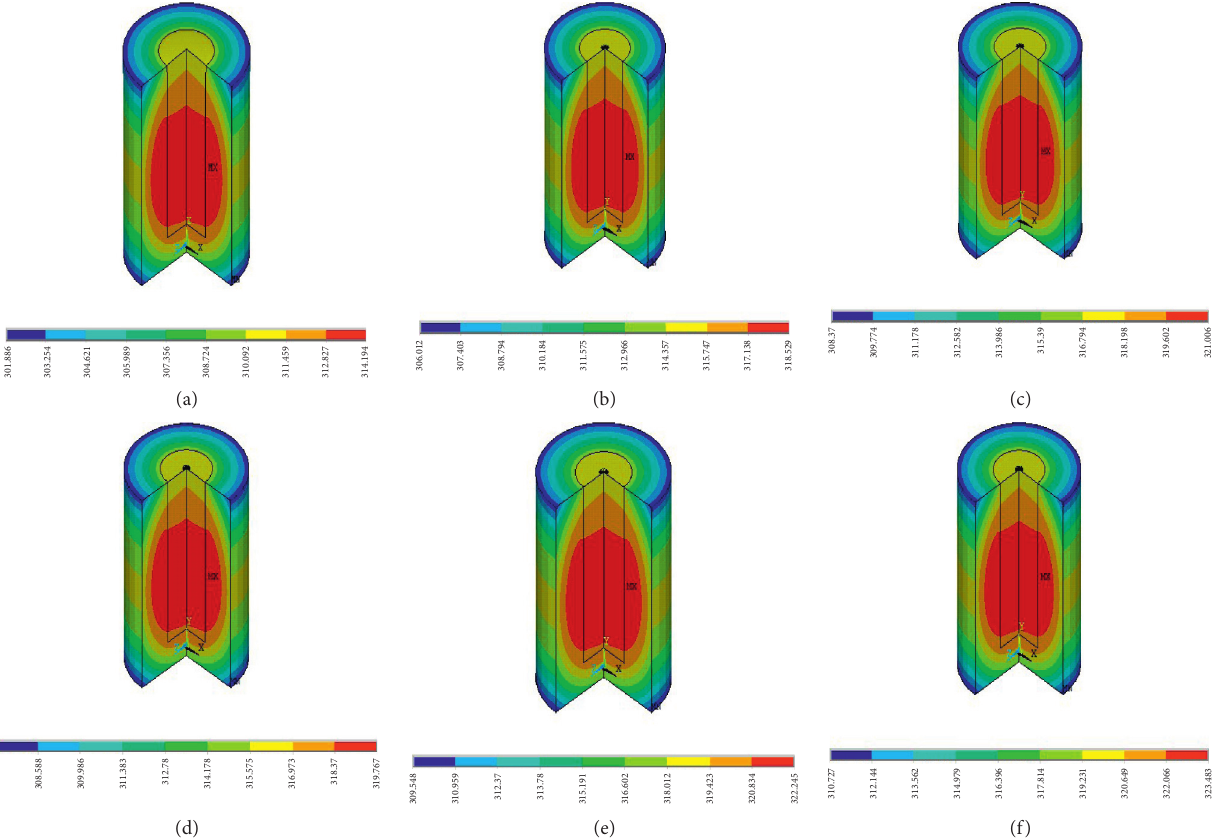
Figure 6: Temperature dispersion in the composites at various squeeze pressures up to 800 seconds: (a) 0MPa; (b) 30MPa; (c) 50MPa; (d) 70MPa; (e) 100MPa; (f)